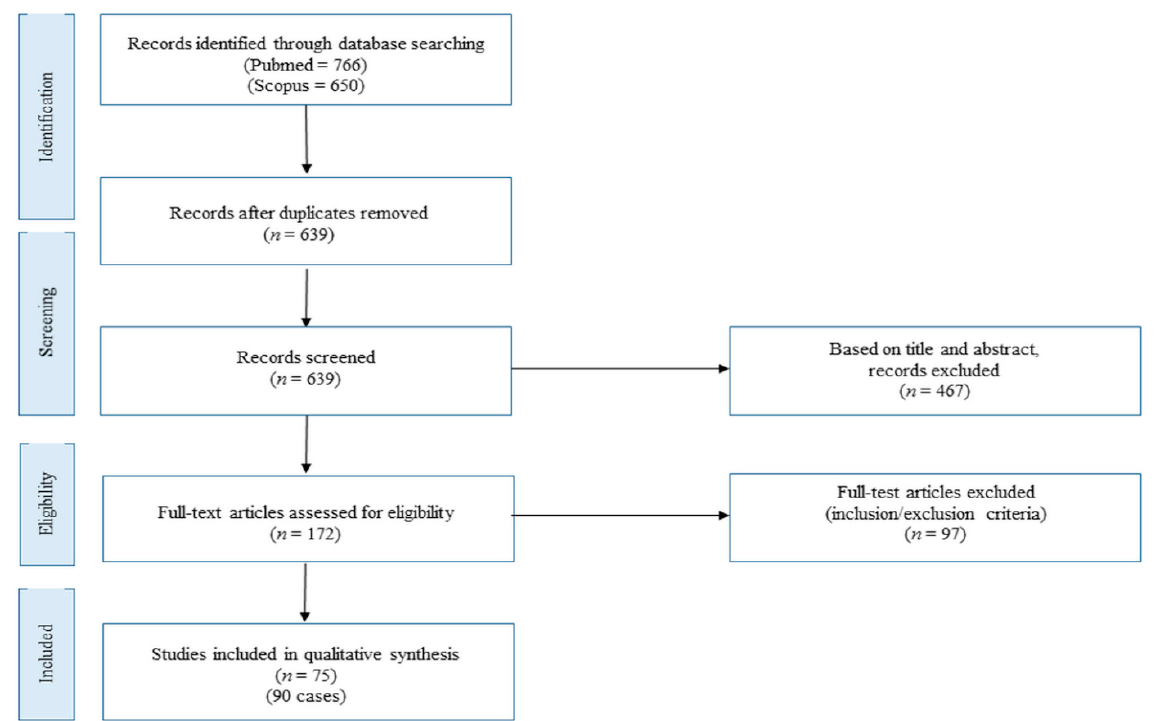
Figure 1. Literature review flow-chart.